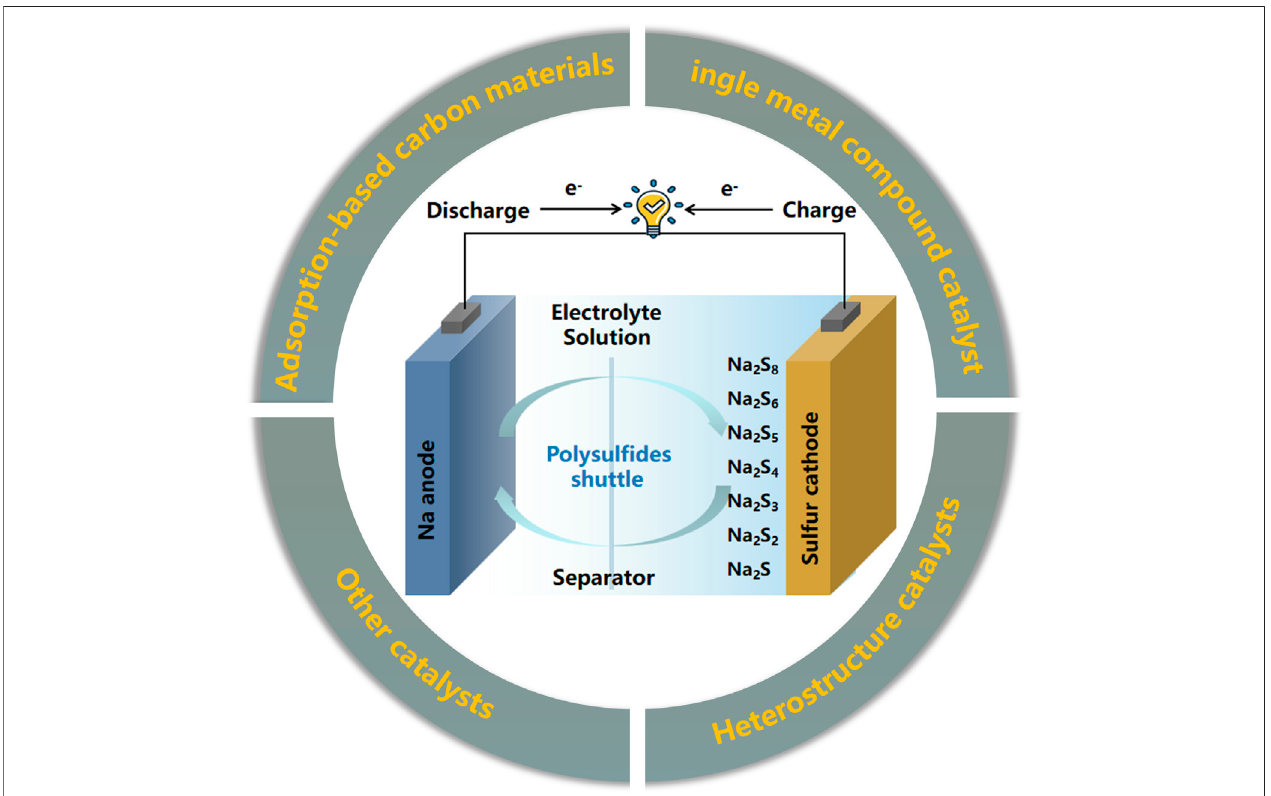
FIGURE 1 | Schematic diagram of the construction strategy of carbon-based cathode materials for room temperature sodium-sulfur batteries (Wang, et al., 2021a).